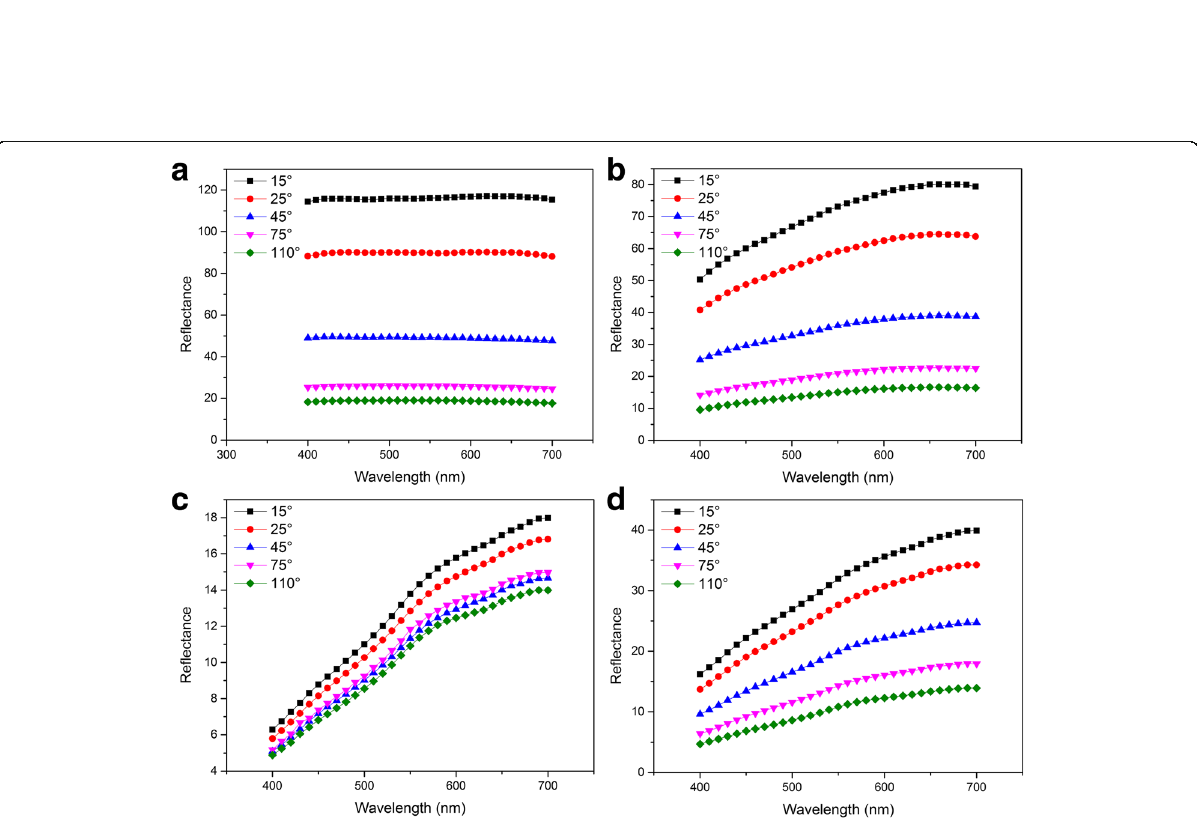
Fig. 3 The visible reflectance spectra via variable angles of Al/MnO 2 composite pigments with a aluminum flake, b S2, c S3, and d